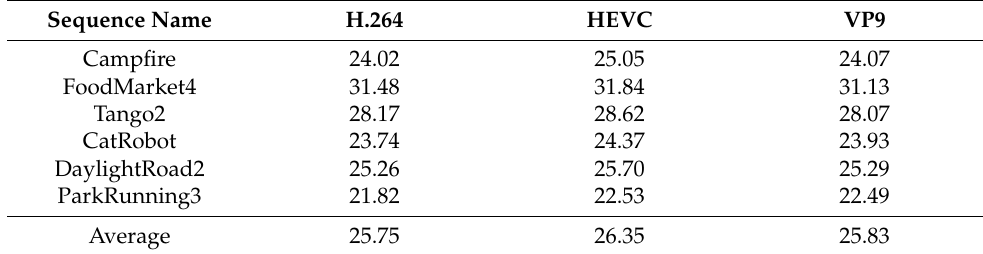
Table 8. PSNR (dB) compared with the conventional method for each